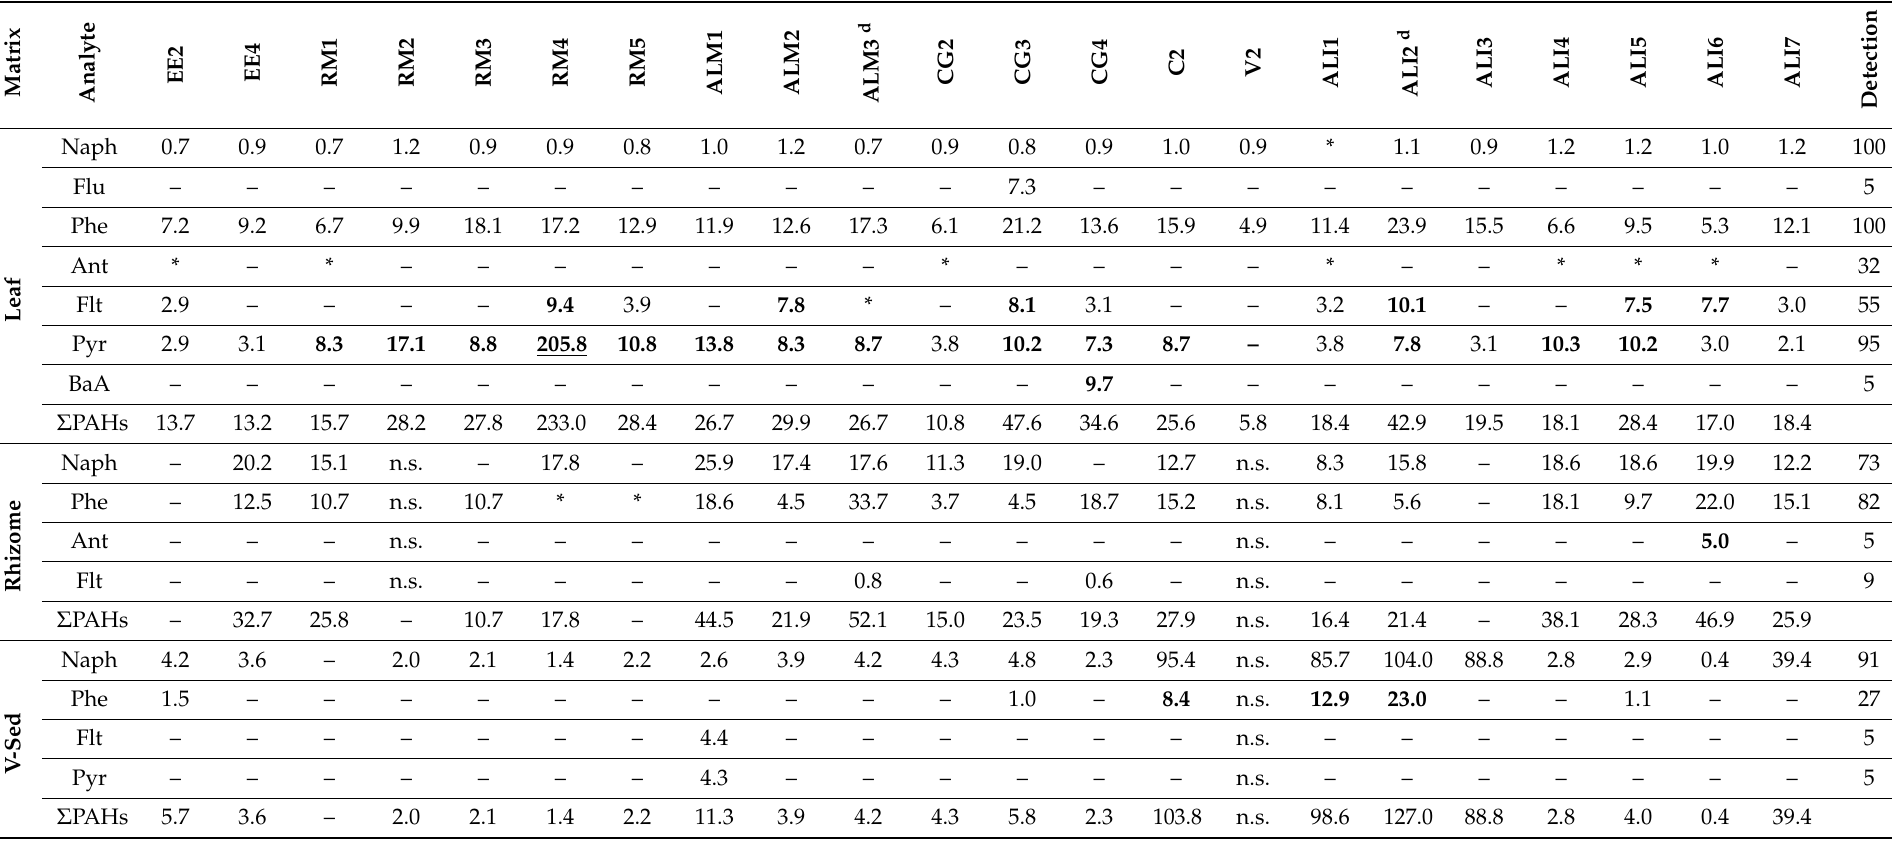
Table 1. PAH congeners ( µ g kg − 1 d.w.) observed in leaves, rhizomes, and sediments (V-sed. NV-Sed and NMR-Sed) from the Almeria, Murcia and Alicante coastal regions compared to BAC a , EAC b and ERL c concentrations. Detection is expressed in